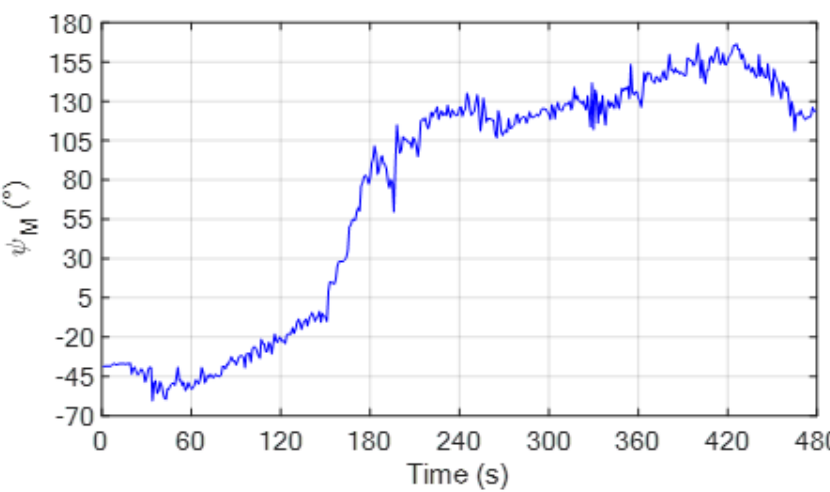
Figure 5. Time variation of the non-calibrated magnetic heading ( ψ M ), obtained applying (4), during the flight test with a fixed deputy. The local magnetic declination at the test site and date of the experiment is 3.07 ◦ .